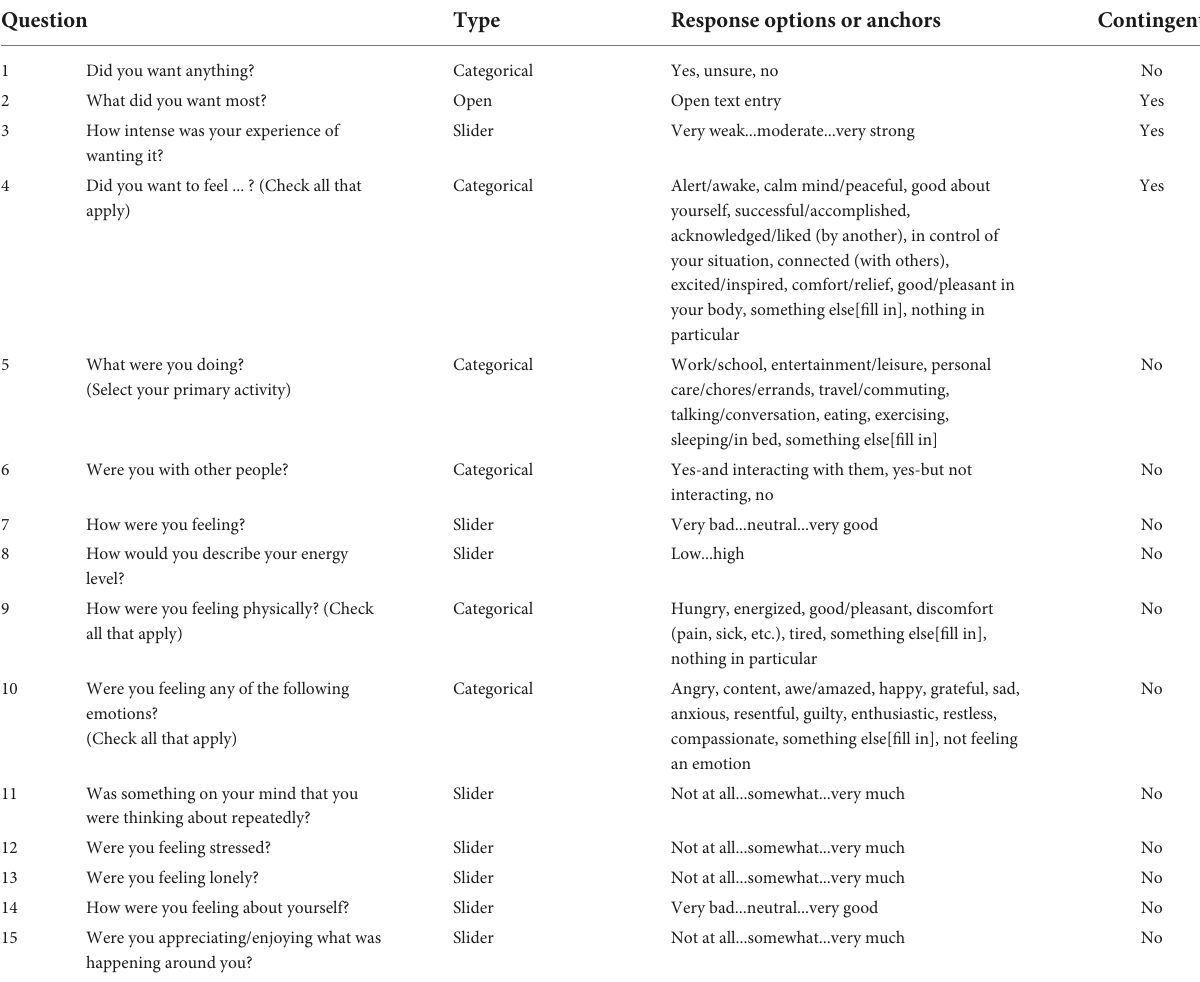
TABLE 1 Experience sampling